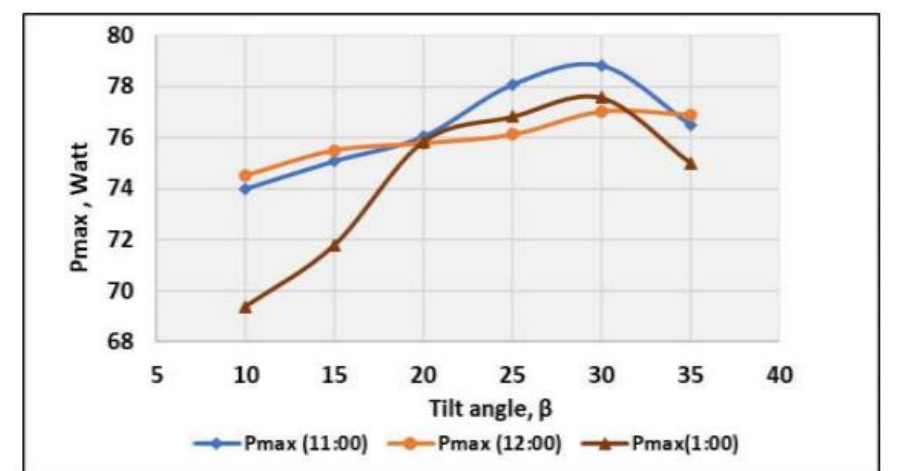
Figure [10]. Performance of PV panel for day (16 September) at tilt angle 30